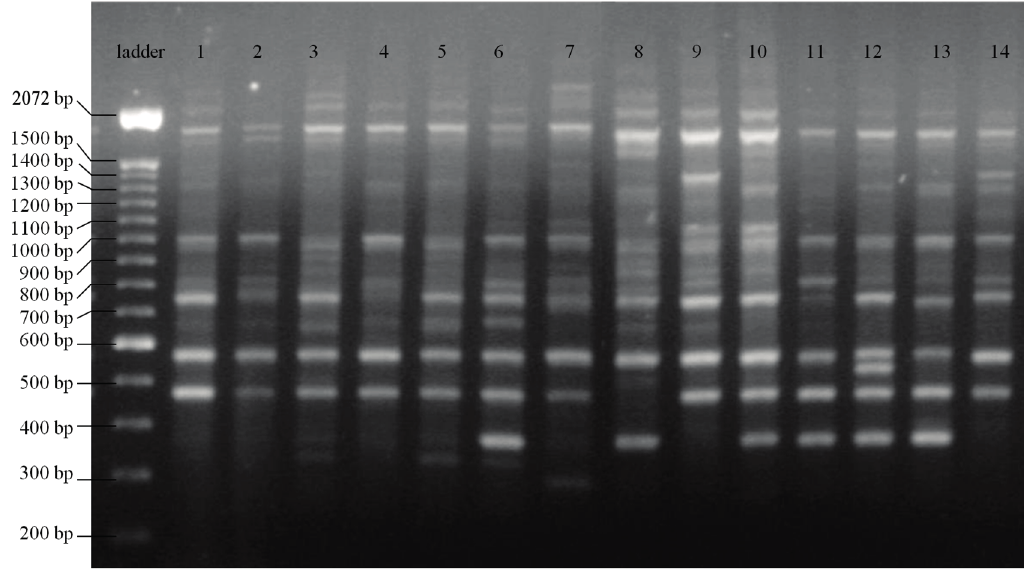
Figure 1. Inter Simple Sequence Repeat (ISSR) profiles of Salvia lachnostachys Benth. collected in Paraná State, Brazil, obtained with primer (CTC) 4 RC, first lane: marker of